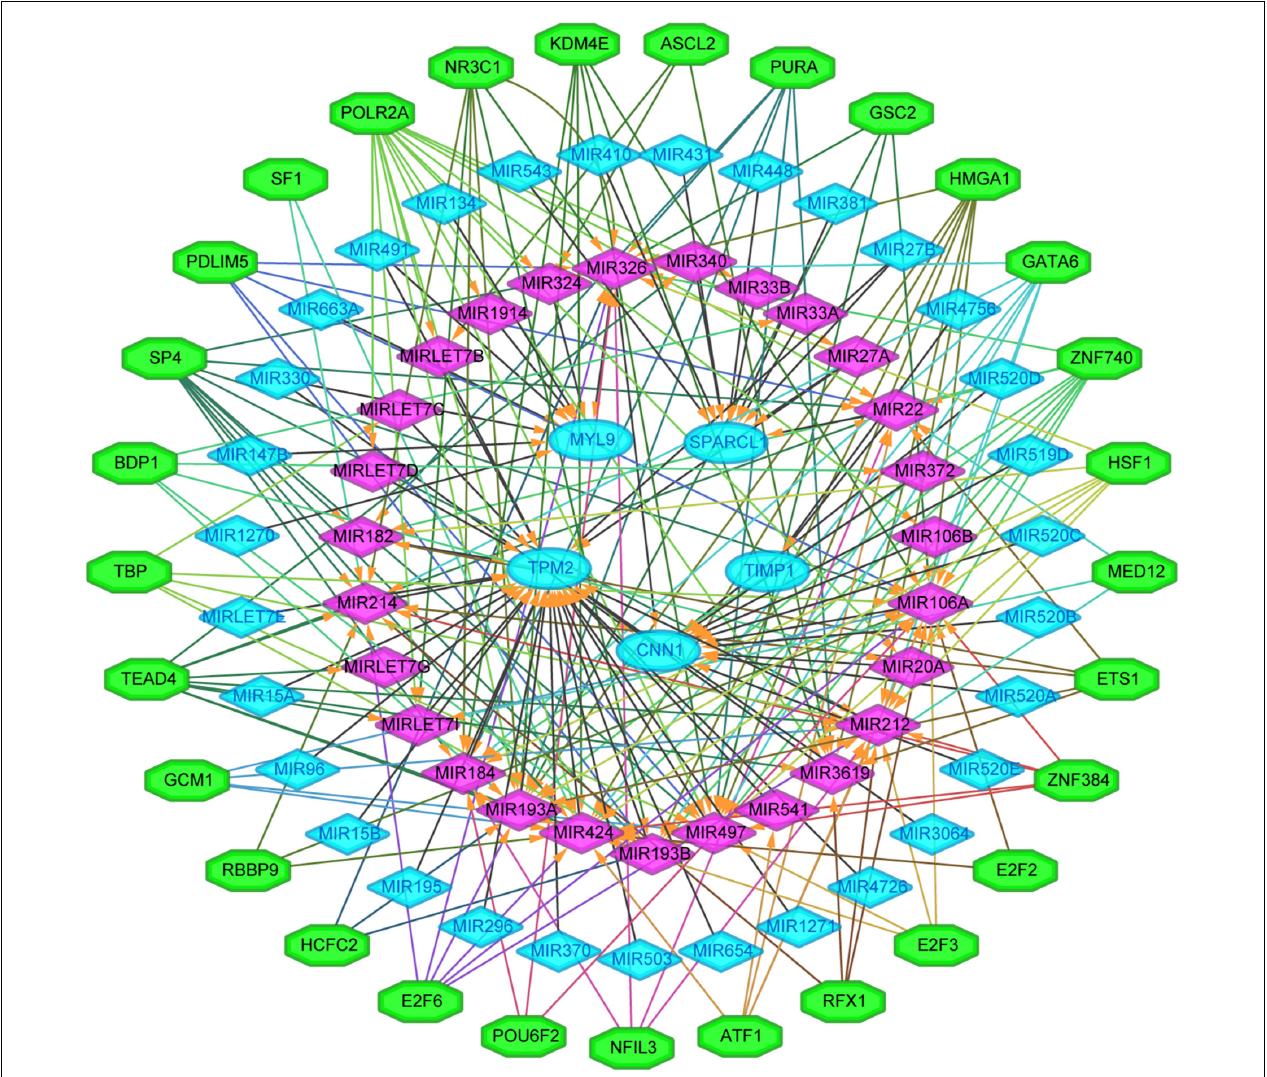
FIGURE 10 | The transcriptional regulatory network of the five hub genes, miRNAs, and TFs. miRNAs, microRNAs; TFs, transcription factors. A green hexagon node represented the TFs, and a pink diamond node represented regulated miRNA, a light blue circular node represented the hub gene, their interaction was represented by an arrow. The numbers of arrows in the networks demonstrate the contribution of one TFs to miRNAs or one miRNA to the hub genes, and the higher the degree the more central the nodes were within the network.